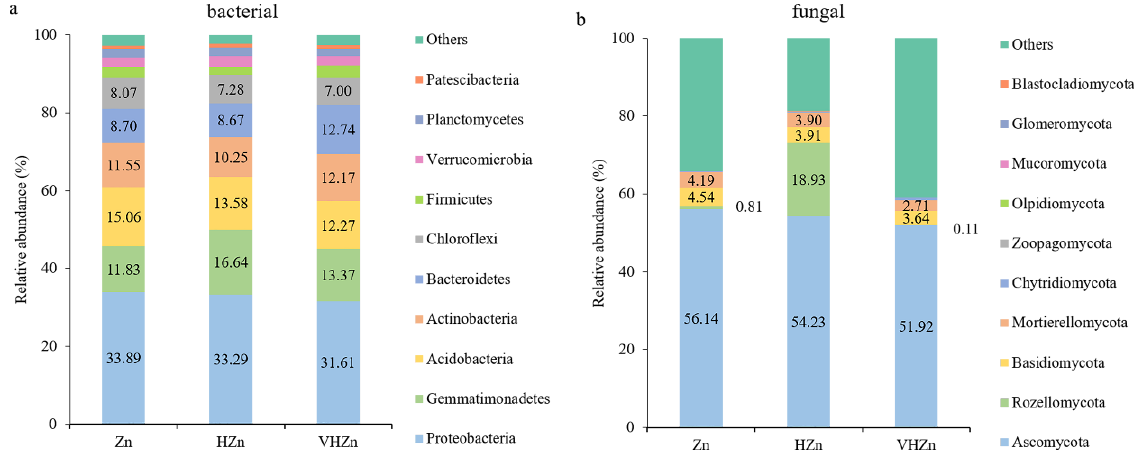
Figure 5. Relative abundances of the top classified phyla of bacterial ( a ) and fungal ( b ) communities in rice rhizosphere soil with different levels of Zn (Zn: 10 mg . kg −1 soil; HZn: 200 mg . kg −1 soil; VHZn: 400 mg . kg −1 soil).